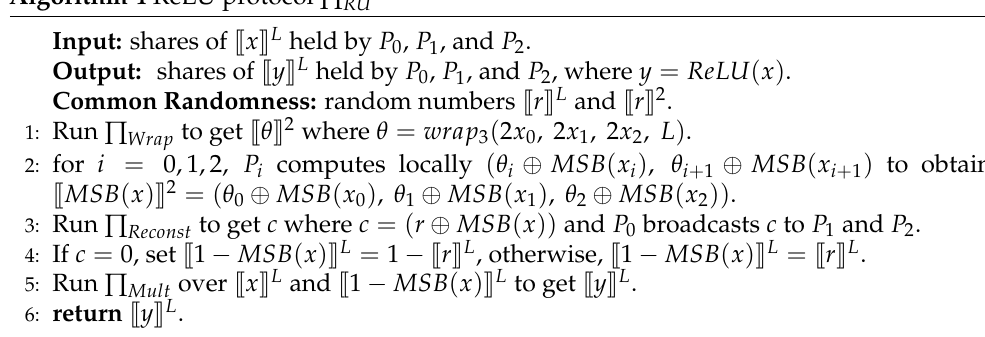
Algorithm 4 ReLU protocol ∏